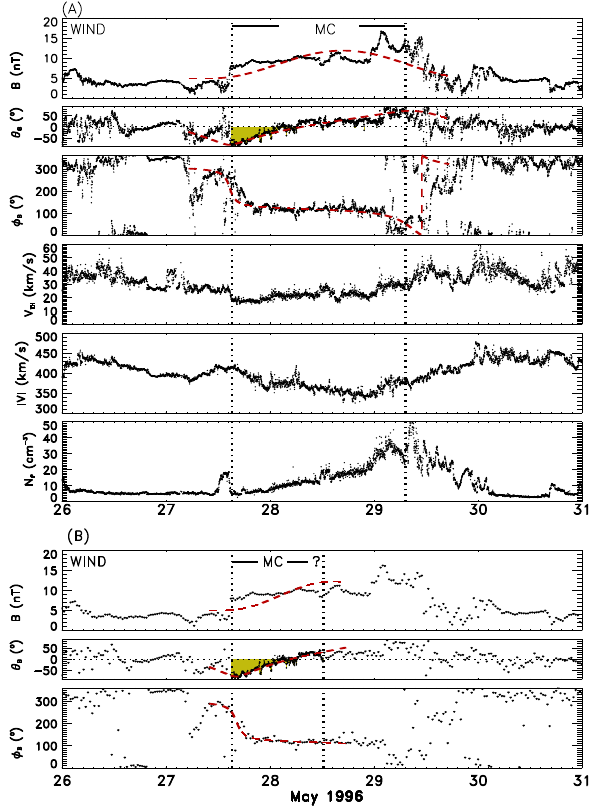
Fig. 9. Two attempts to fit the same MC: (A) Comparison between the observed field and the force-free MC model fit (smooth dashed curves) to these data in terms or field magnitude ( | B | ) and direction (longitude and latitude angles, φ B , θ B ) (also shown: proton thermal speed, bulk speed, and density) for the MC of 27 May 1996. The fit- ted curves hold strictly only within the vertical dashed lines, which represent the estimated endpoints of the MC. The full interval of this MC, where the duration was a long 40h, is fitted with moderately good success. (B) Now for convenience only 30min.- averages of the field are shown. In (B) only part of the MC was fitted with the same model, where the duration was incorrectly assumed to be 21h, which interestingly provided almost the same fit-parameters values as those from the (A)-interval fitting, including very nearly the same estimated radius. The model occasionally displays this robust fea- ture. This is a Q 0 =2 MC. The regions shaded in yellow are where the observed B z component is